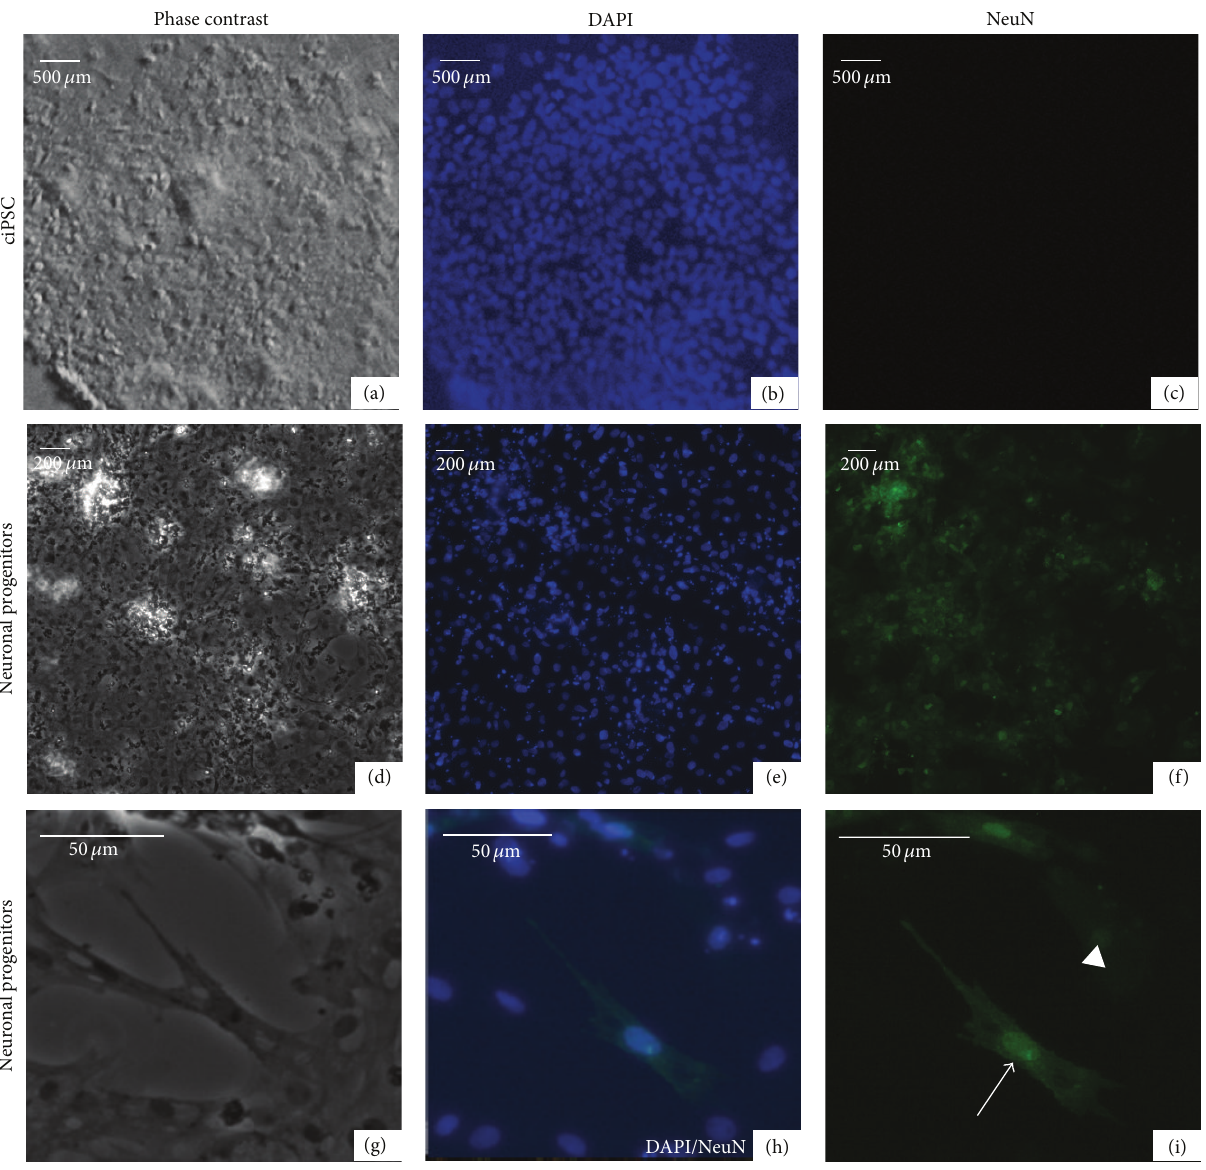
Figure 6: Neuronal marker staining of differentiating neurons. ((a)–(c)) Undifferentiated chicken iPSC-like cells under phase contrast (a) or with fluorescence for DAPI (b) and NeuN (c) stains. ((d)–(f)) Neuronal differentiated chicken iPSC-like cells under phase contrast (d) or with fluorescence for DAPI (e) and NeuN (f) stains at day 7. ((g)-(h)) A close-up of single cells labeled for NeuN and DAPI. In the close-up, we chose a region with fewer NeuN labeled cells in order to show the contrast between labeled and unlabeled cells. Arrow, example of strongly labeled NeuN cells; arrowhead, example of moderately labeled NeuN cells. The control iPSC-like cells had nearly no labeled cells (only 0–2 per entire well or